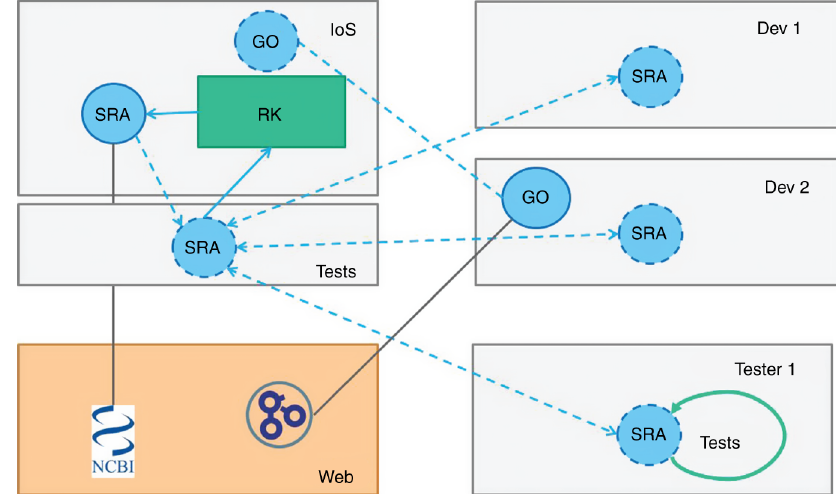
Figure 2: The possible process of promoting a tool to the production level. The orange box represents online services such as NCBI ’ s SRA and gene ontology (GO). To access such services tools can be developed (blue circles). IoS represents the production level where in this picture only SRA has a connector. The GO connector node is submitted for inclusion into the production level but has no tests yet and therefore is not scheduled for the review committee (RK; green box), yet. Developers Dev 1 and Dev 2 both pulled copies of the SRA connector node for further development while Tester 1 pulled a copy for the development of additional tests. Tests are one evidence for the decision of the review committee whether to include a tool into the production level but code review and additional steps should also be taken. The RK requests and reviews tests, as well, to ensure proper procedure. The RK is composed of researchers form the relevant field, computer scientists and other